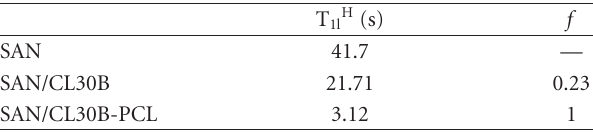
Table 2: T 1lH relaxation time and f parameter, that is, the fraction of polymer/clay interface e ff ectively formed with respect to the maximum amount of polymer chains that could fit around individual nanoplatelets, for SAN/CL30B and SAN/CL30B-PCL with 3wt% of inorganics. T 1lH (s) f SAN 41.7 — SAN/CL30B 21.71 0.23 SAN/CL30B-PCL 3.12